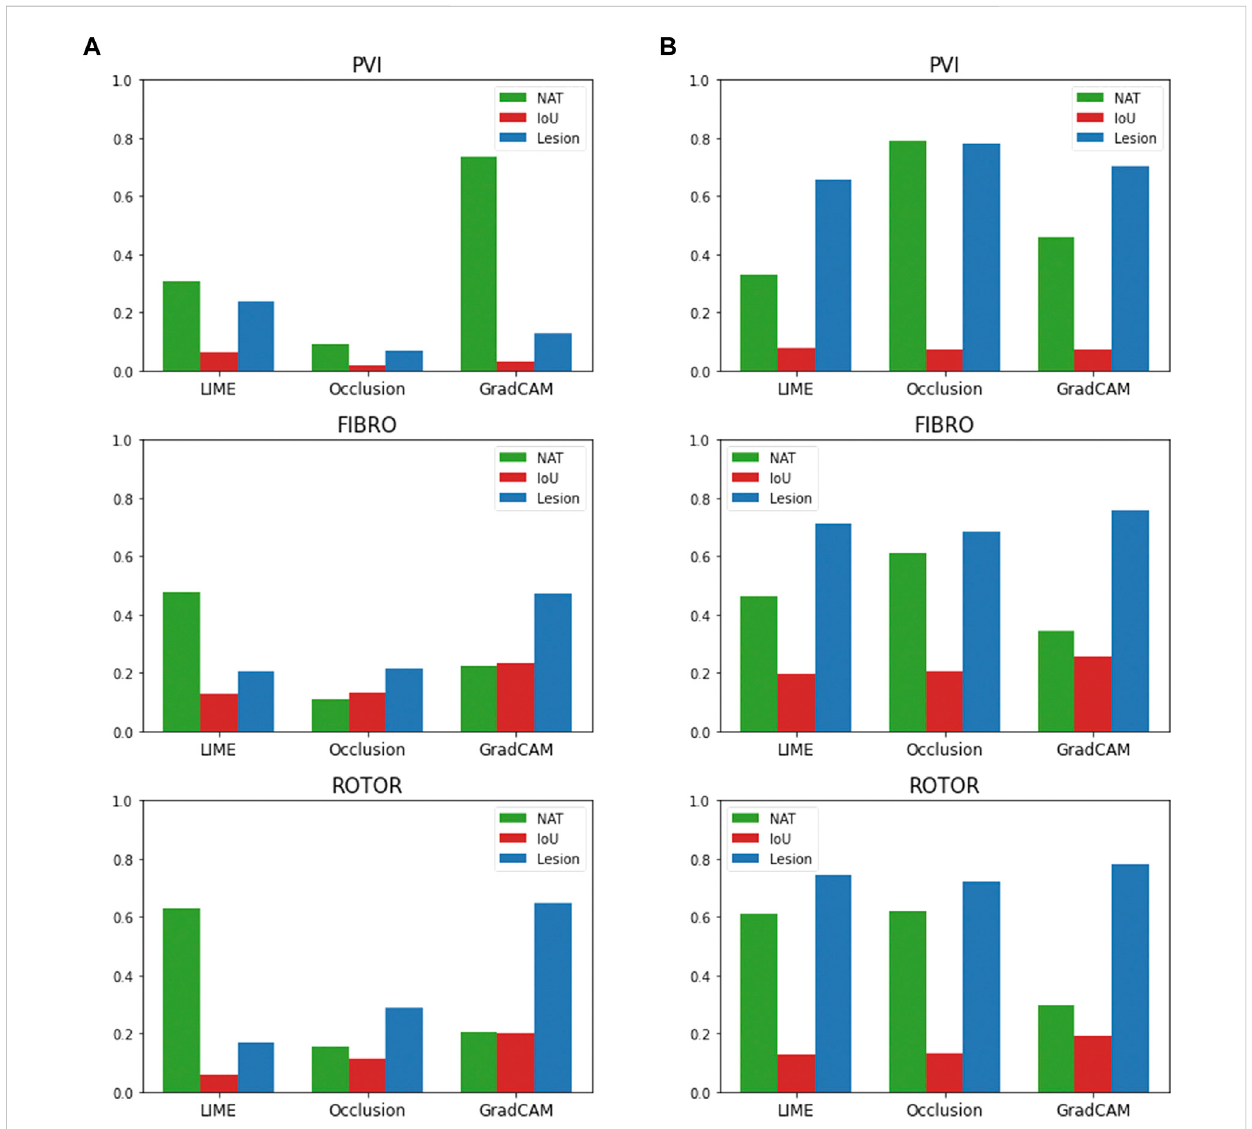
FIGURE 7 IoU, lesion and NAT percentage values for each interpretability method and ablation strategy with altered informative region threshold value. (A) . Informative region threshold value 25% above the average FA. (B) . Informative region threshold value 25% below the average FA.